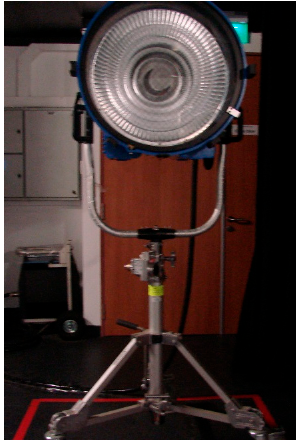
Figure 8. Light source for solar simulator.